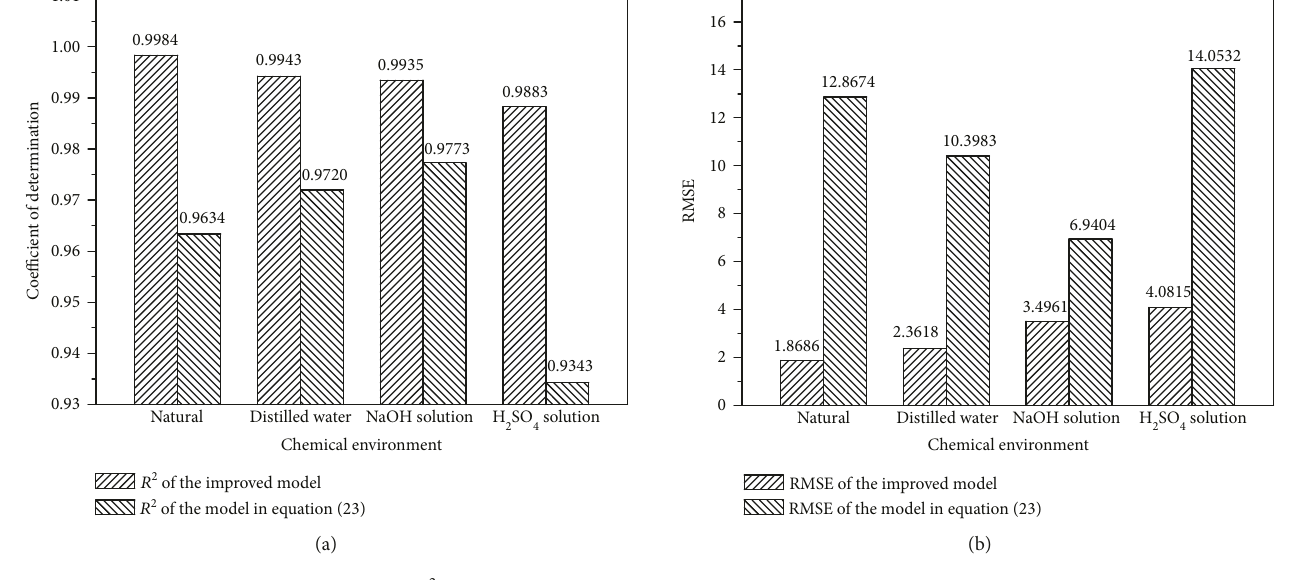
Figure 6: R 2 and RMSE between the two models and experimental